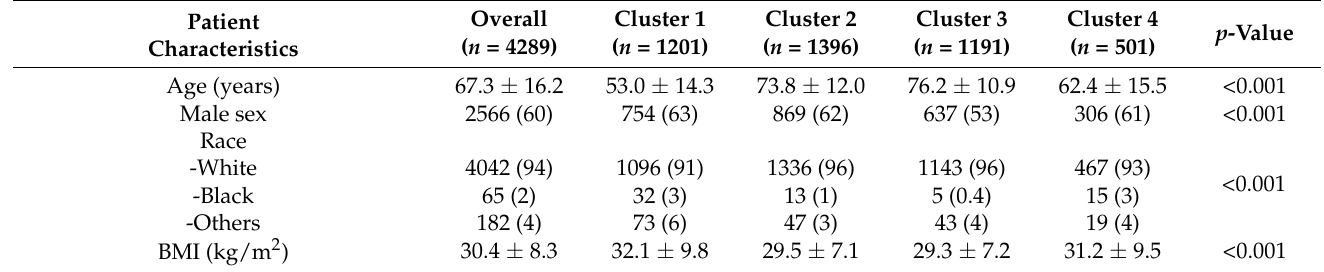
Table 1. Baseline clinical